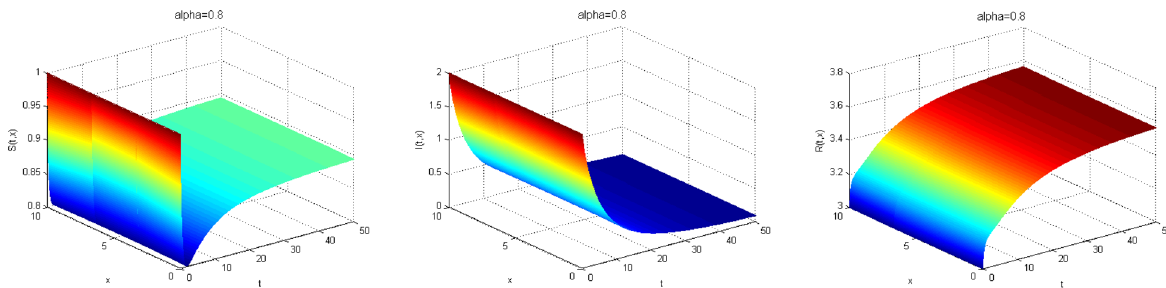
Figure 10. Behavior of the solution for α = 0.8 under the effect of vaccine ( u = 0.8